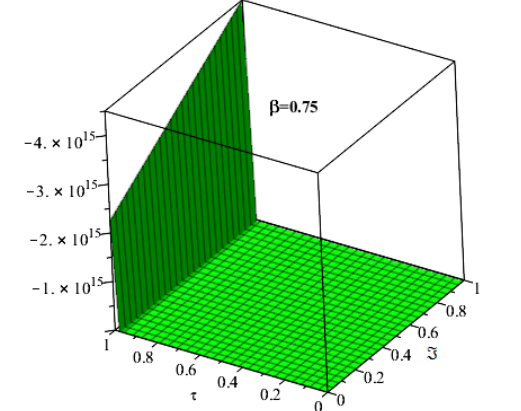
Figure 17. The solution of fractional-order β = 0.75 of Example